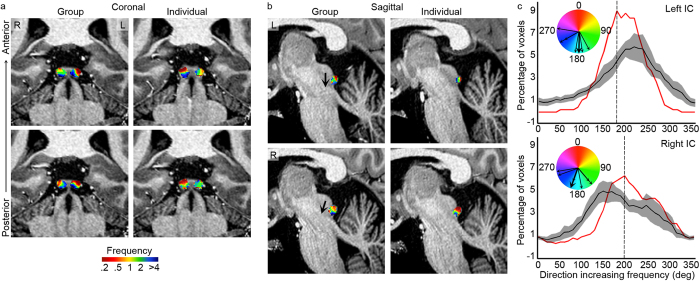
Group and individual tonotopy in the IC.(a,b) Maps of frequency preference (tonotopic maps) in the group (first column) and in an individual (S1; second column), within regions responding significantly to the natural sounds. Coronal (a) and sagittal (b) views of the maps are superimposed on high-resolution anatomical images of the individual subject. Coronal views of two locations on the anterior-posterior axis are shown from top to bottom, and for the sagittal views a cut through left (top) and right (bottom) IC are displayed. (c) Distribution of direction of increasing frequency, calculated on individual voxels in sagittal slices (4 slices for the left and right IC each). Red and black lines show the direction of increasing frequency for the group tonotopy map and the average of distributions resulting from individual maps, respectively (±s.e.m. in grey). Black arrows in the coloured circles represent the peak of red curve (thick arrow, representing the main direction of increasing frequency in the group tonotopy map), and peaks of the individual distributions (thin arrows, representing the main direction of increasing frequency in the individual tonotopy maps; subjects with the same peak value are displayed as additional arrowheads).